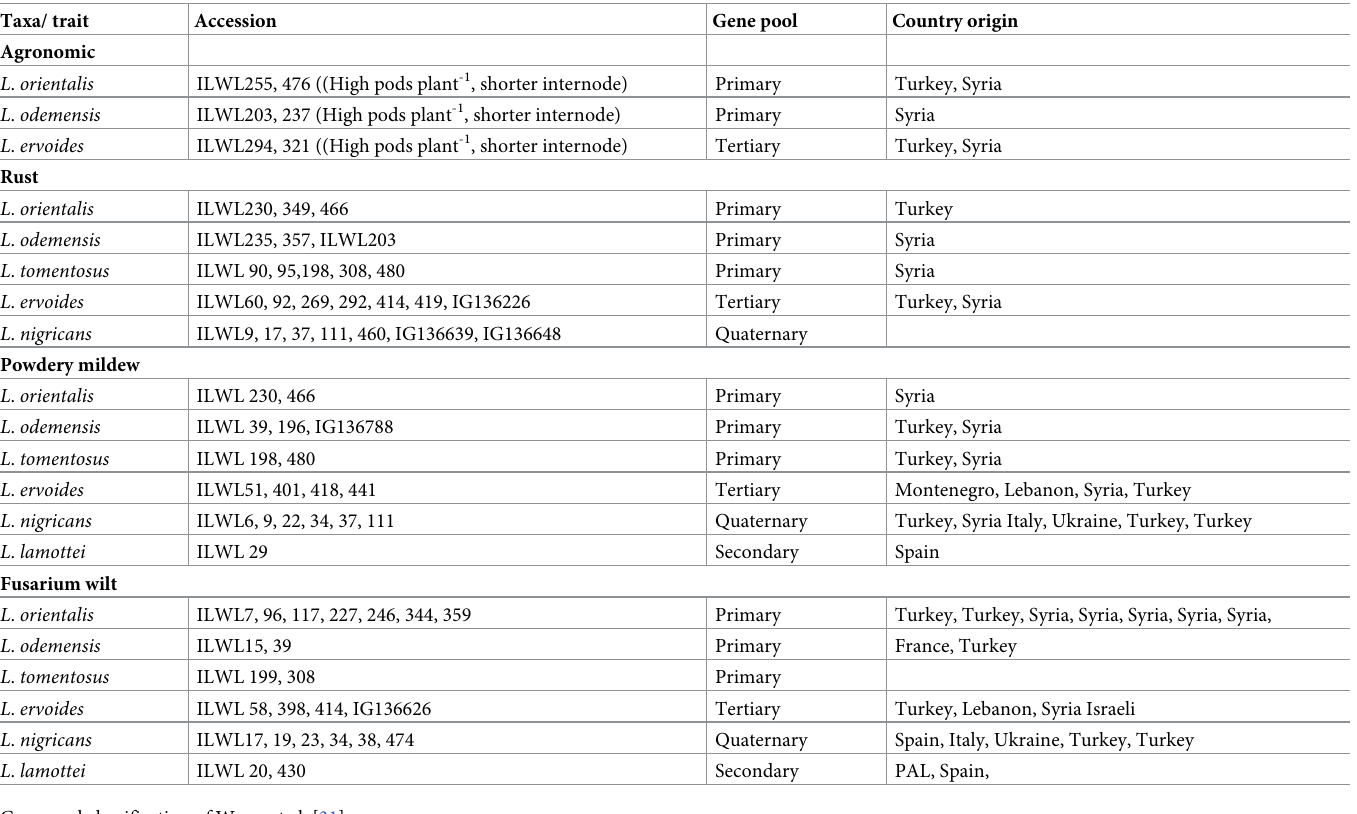
Table 5. Identification of donor accessions for their introgression to lentil genetic improvement against important agronomic and major biotic stress related traits. Taxa/